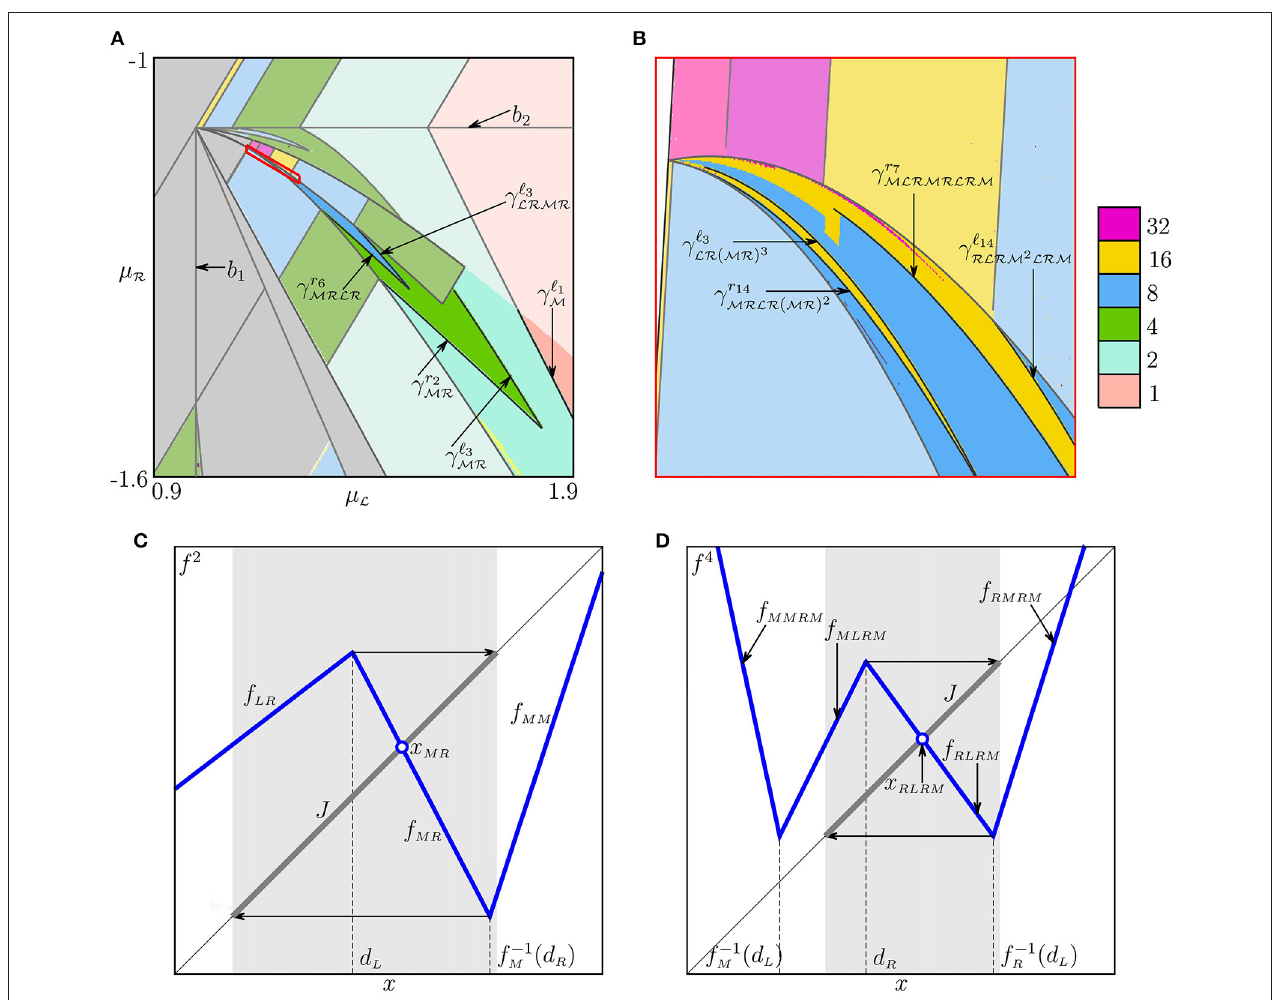
FIGURE 15 | (A) Chaoticity regions located between D L , LR st and D R ,2, LR st ; In (B) the region outlined red in (A) is shown enlarged. (C) Local absorbing interval of f 2 including d L for p 6∈ D L , LR st immediately after crossing b L , LR st . (D) Local absorbing interval of f 4 including d R for p 6∈ D R ,2, LR st immediately after crossing b R ,2, LR